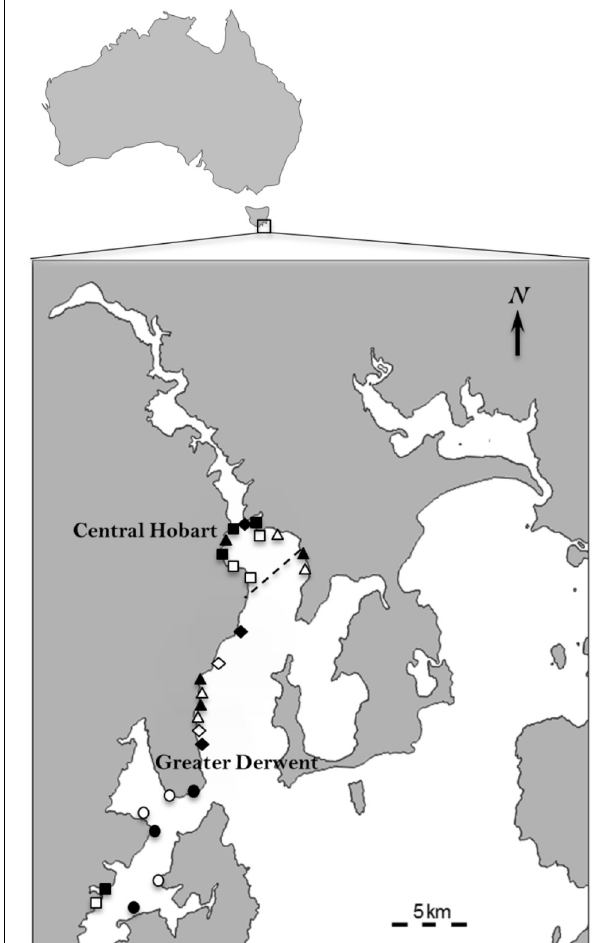
FIGURE 1 | Location of the 27 sites used to test the effects of pollution from anthropogenic point sources on algal and sessile invertebrate recruits in the Derwent and D’Entrecasteaux Channel, Tasmania (43.03 ◦ S 147.34 ◦ E). The dashed line indicates 5 km from Hobart CBD that separates sites in the central Hobart region from the greater Derwent region. Solid symbols are impact sites, open symbols control sites. Diamonds = sewage outfalls, squares = marinas, circles = fish farms, triangles = storm water drains. The study area has a long history of extensive foreshore development, including establishment of commercial and recreational boating marinas, storm water drains and sewage outfalls starting in the early 1900’s, and more recently the introduction of salmon farming in the D’Entrecasteaux Channel in the